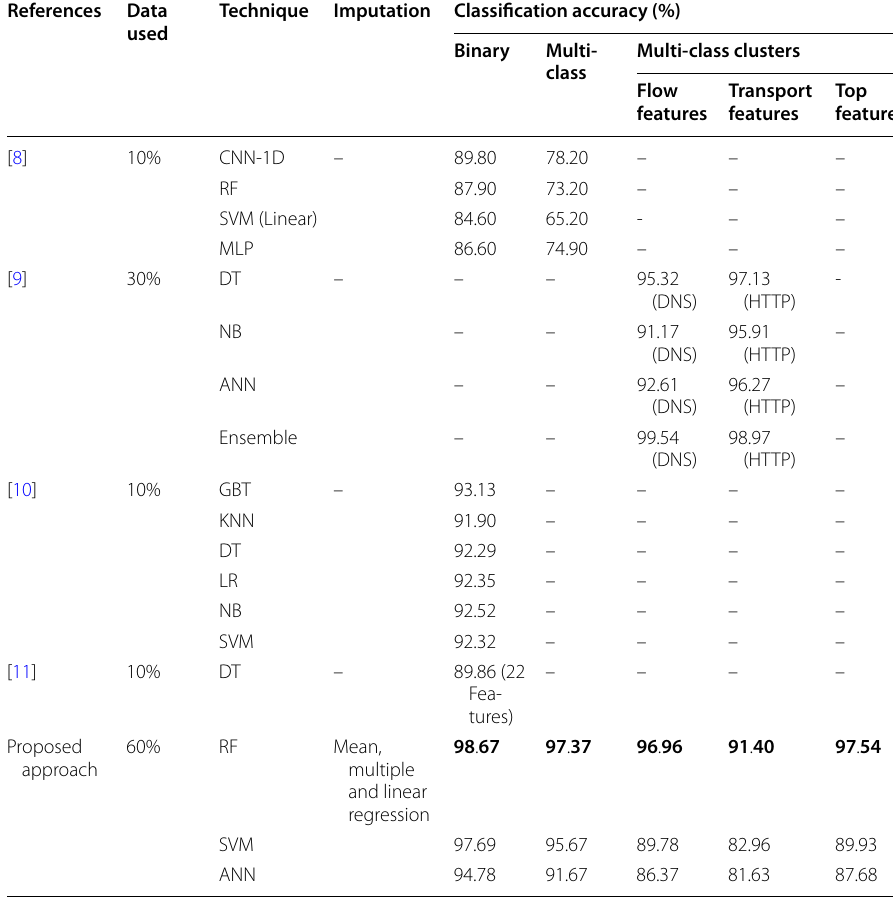
Bold values show highest accuracies achieved by proposed solution